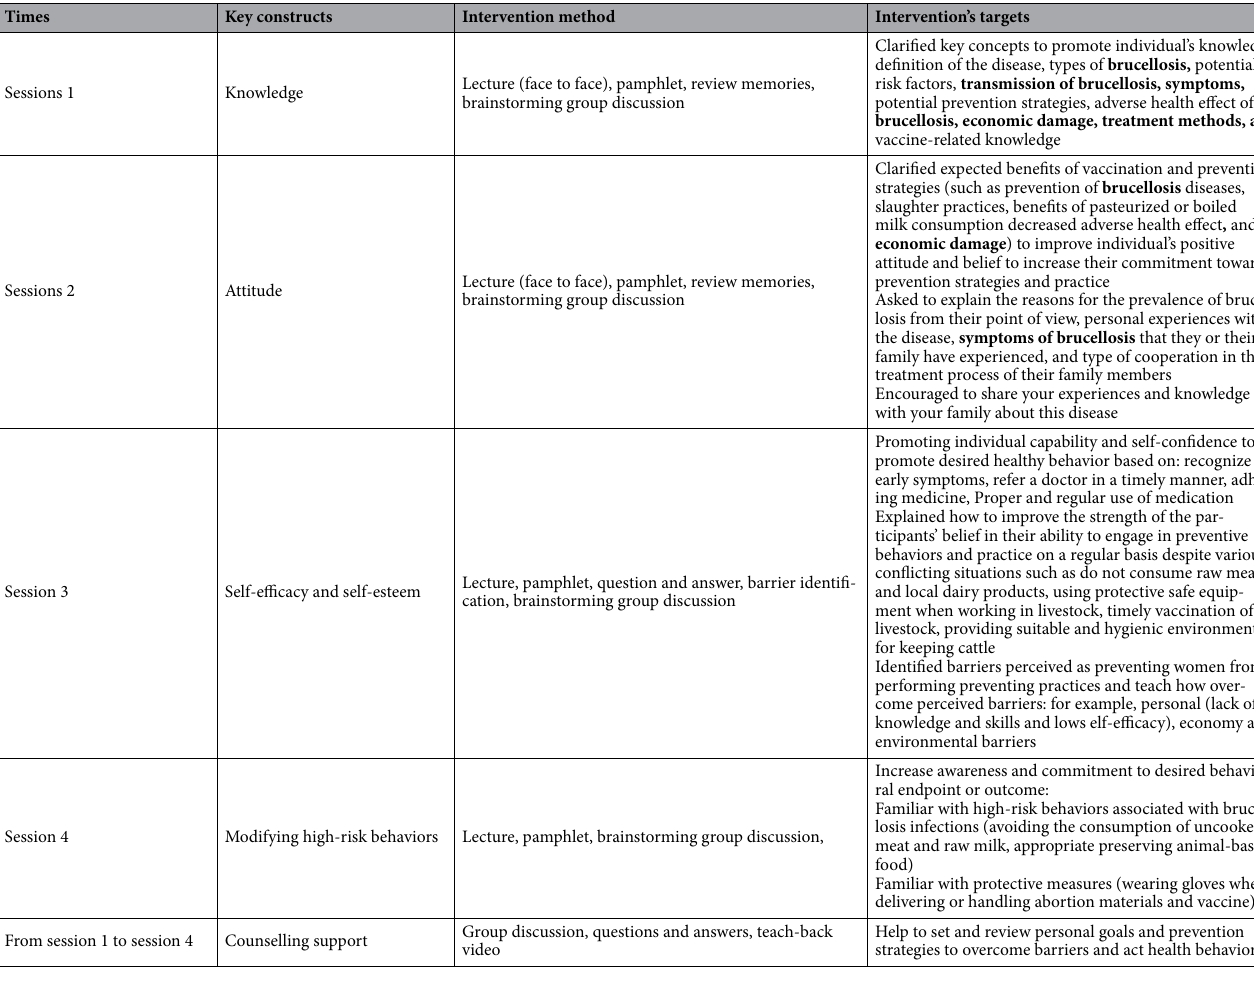
Table 2. Family-centered empowerment model-based educational intervention to improve risk